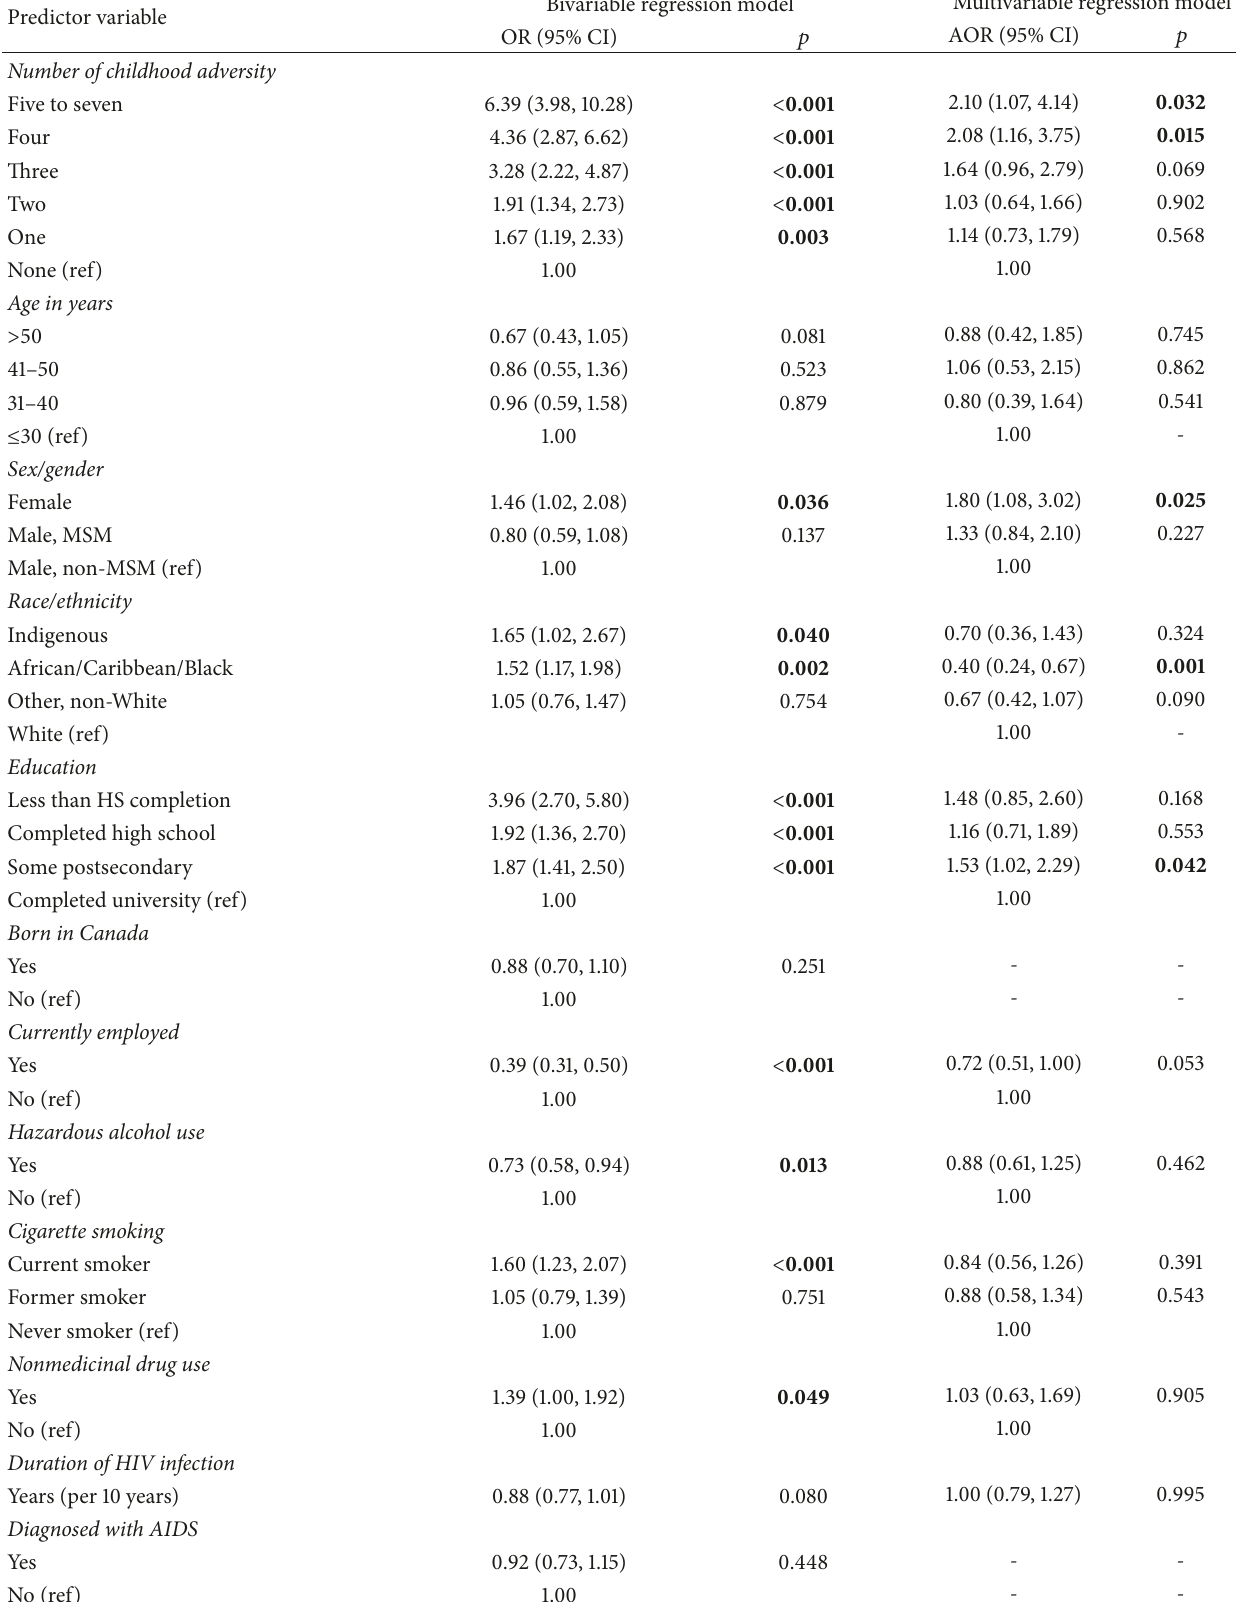
Table 3: Childhood adversities as predictors of depression (CES-D ≥ 16): results from bivariable and multivariable logistic regression models. Predictor